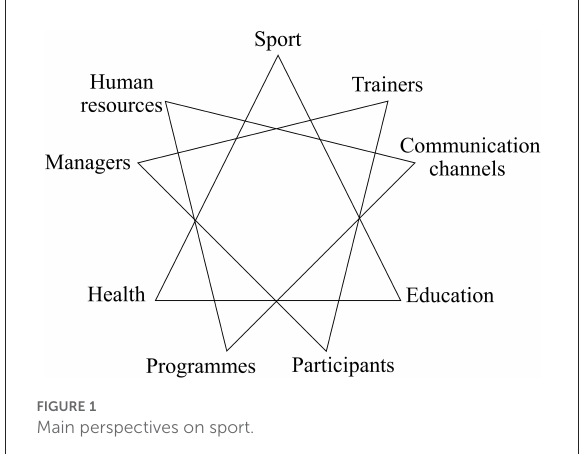
FIGURE1 Main perspectives on